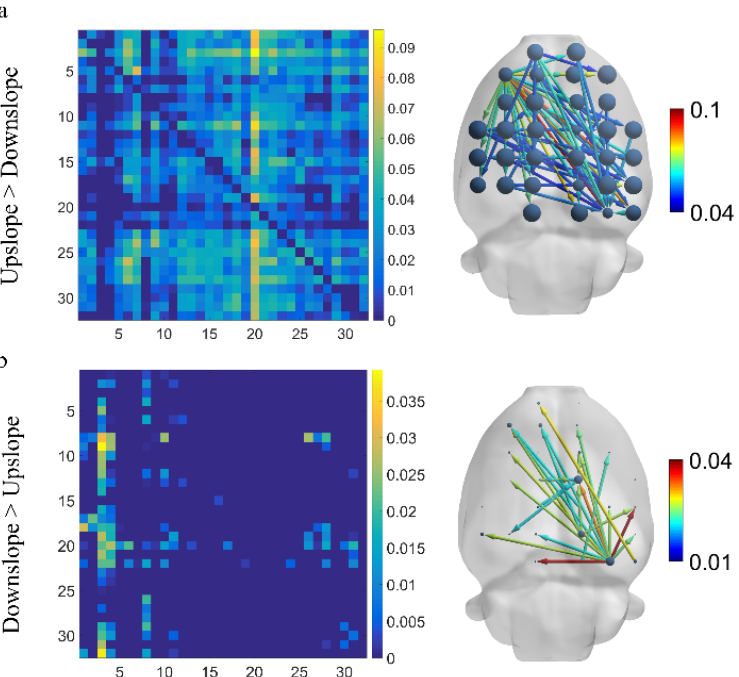
Figure 3. Difference in brain functional directed connectivity for two locomotion states in the full-frequency band (7–100 Hz). ( a ) Increased connectivity in upslope locomotion than downslope locomotion. ( b ) Increased connectivity in downslope locomotion than upslope locomotion. Threshold set to 50% of the strongest connection (i.e., preserving connections exceeding 50% of the strongest connection). The node size denotes the degree, and the edge color represents the connection weight.